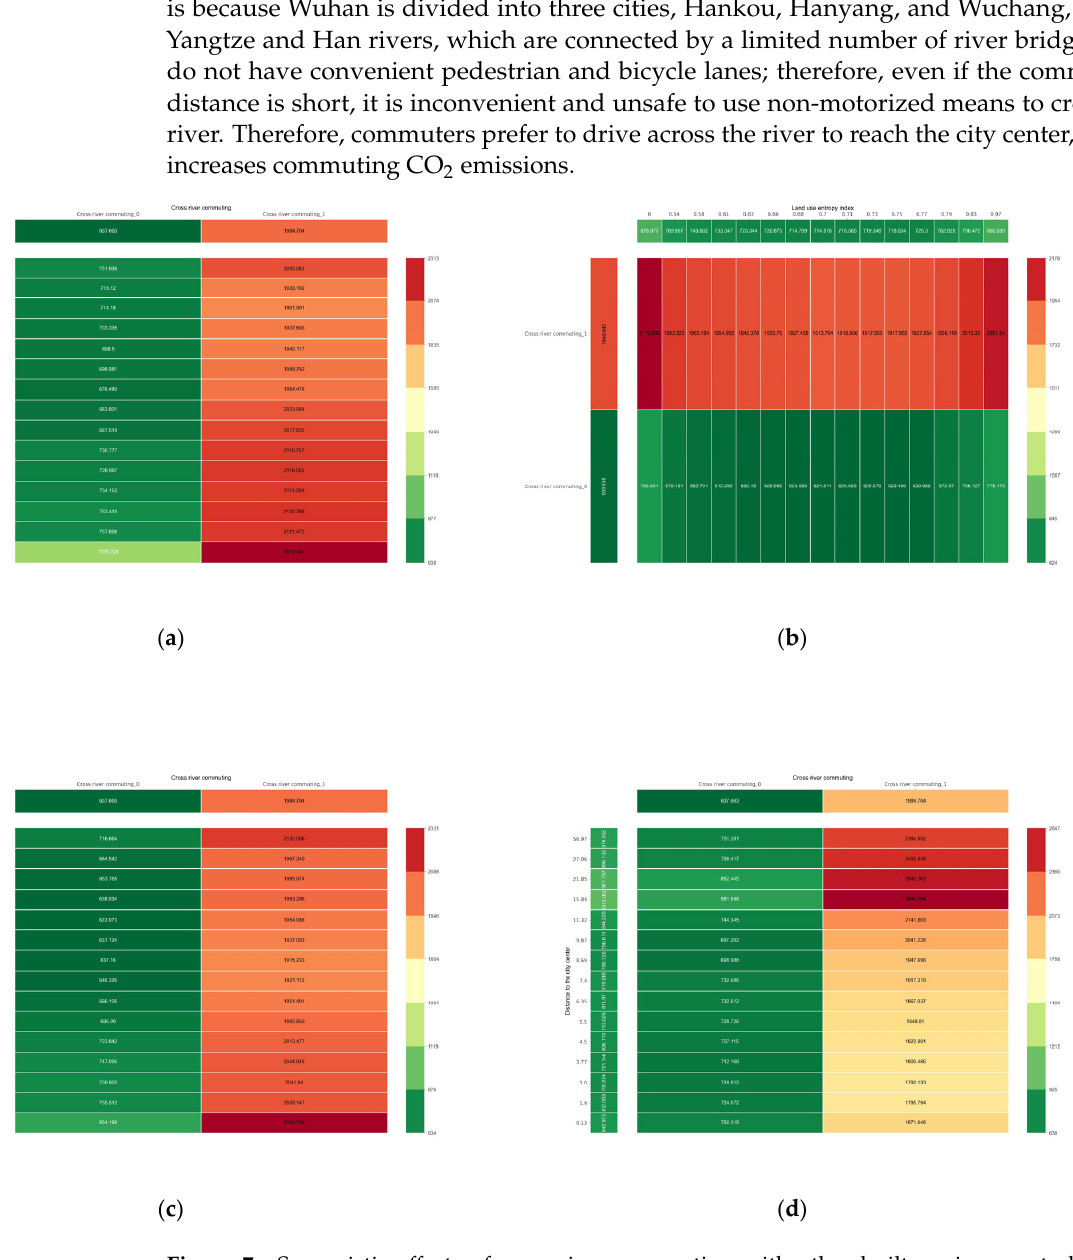
Figure 7. Synergistic effects of cross ‐ river commuting with other built environment elements. ( a ) Synergy of population density and cross ‐ river commuting; ( b ) Synergy of land use entropy and cross ‐ river commuting; ( c ) Synergy of land use intensity and cross ‐ river commuting; ( d ) Synergy of the distance to the city center and cross ‐ river commuting.